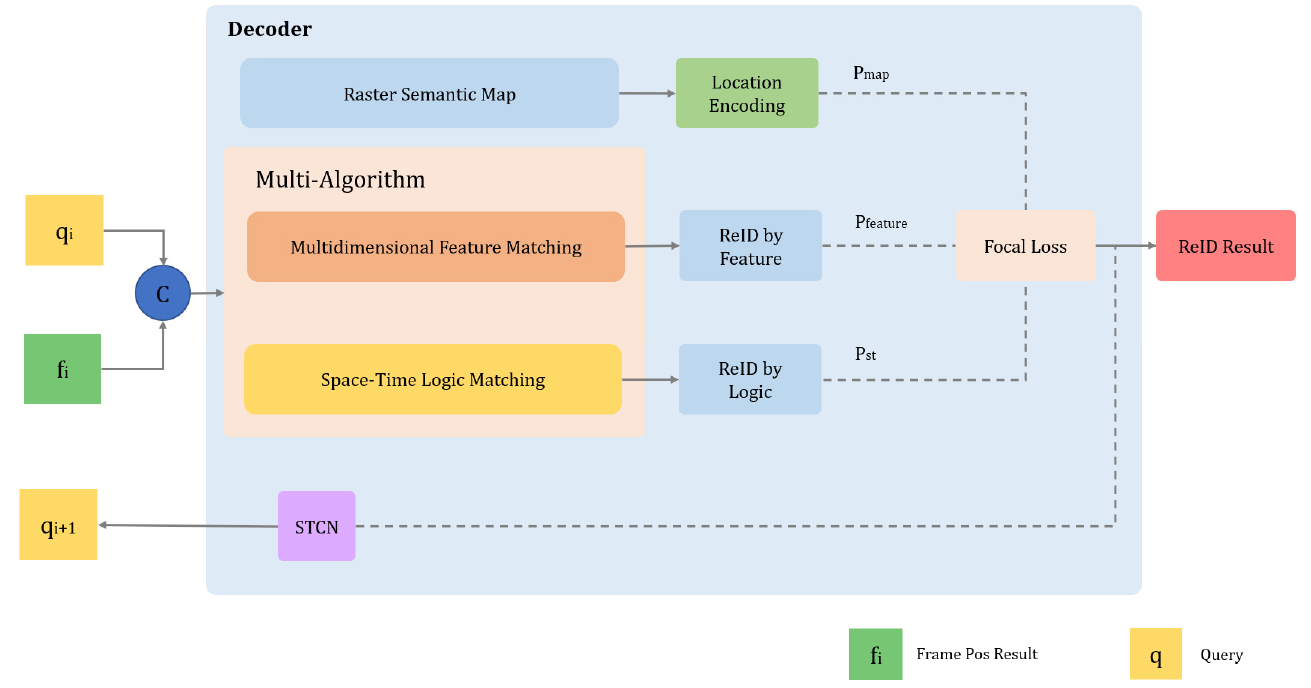
Figure 2. Decoder